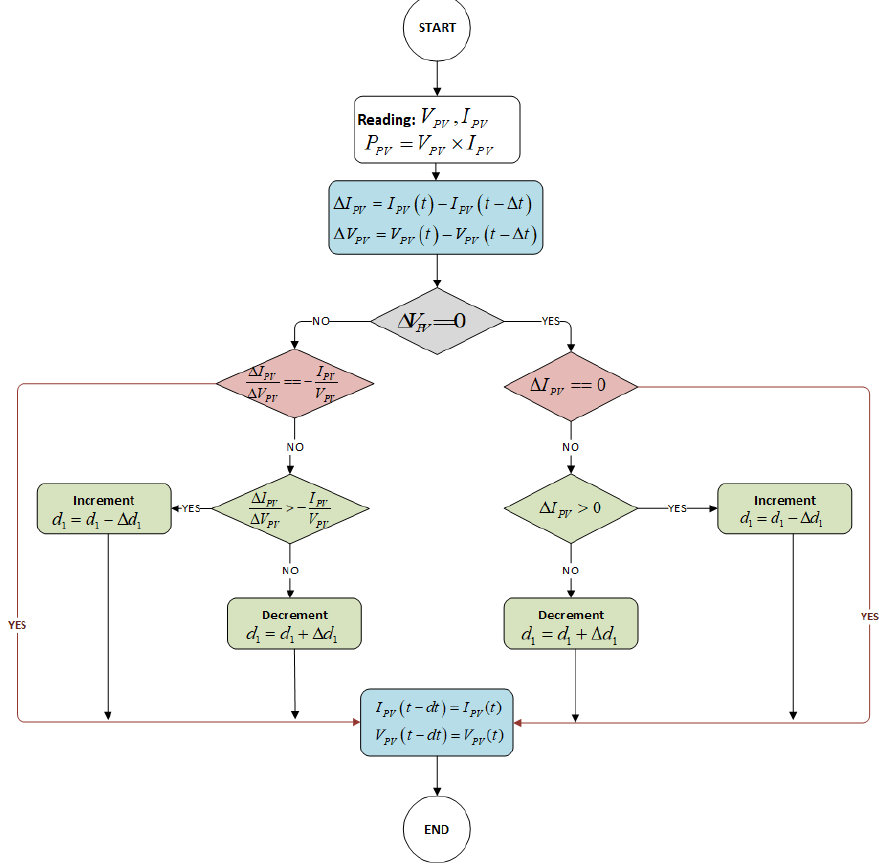
Figure 5. Diagram of the MPPT incremental conductance algorithm.